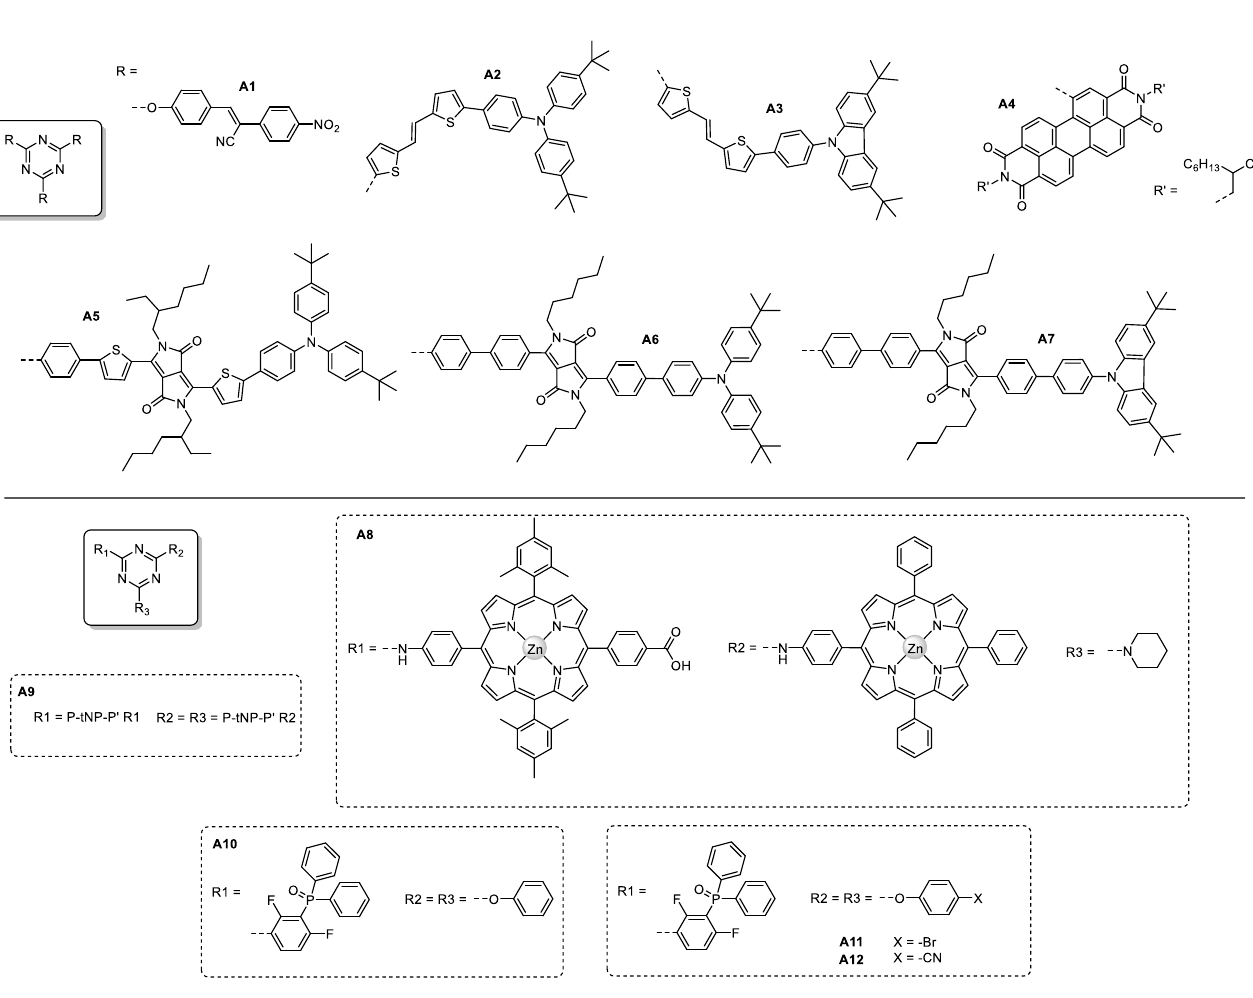
Figure 4. The chemical structures of some representative examples of triazine-based SSCMs.